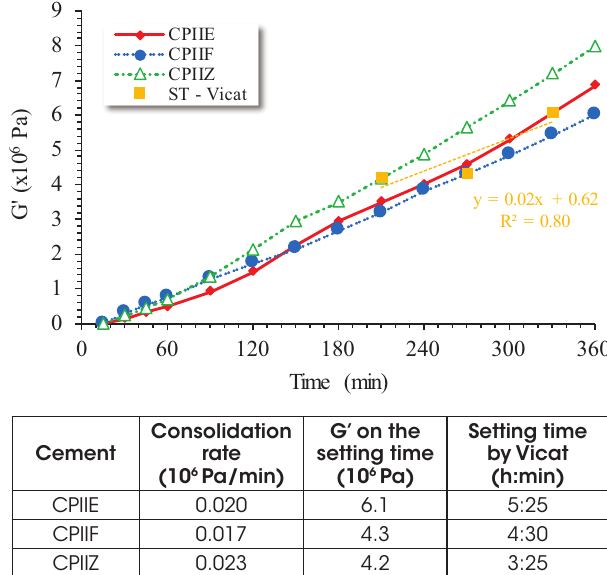
Figure 8 correlates the results of the evolution of G’ versus time. The angular coefficient represented the rate of consolidation: as higher the inclination, higher the cement consolidation rate